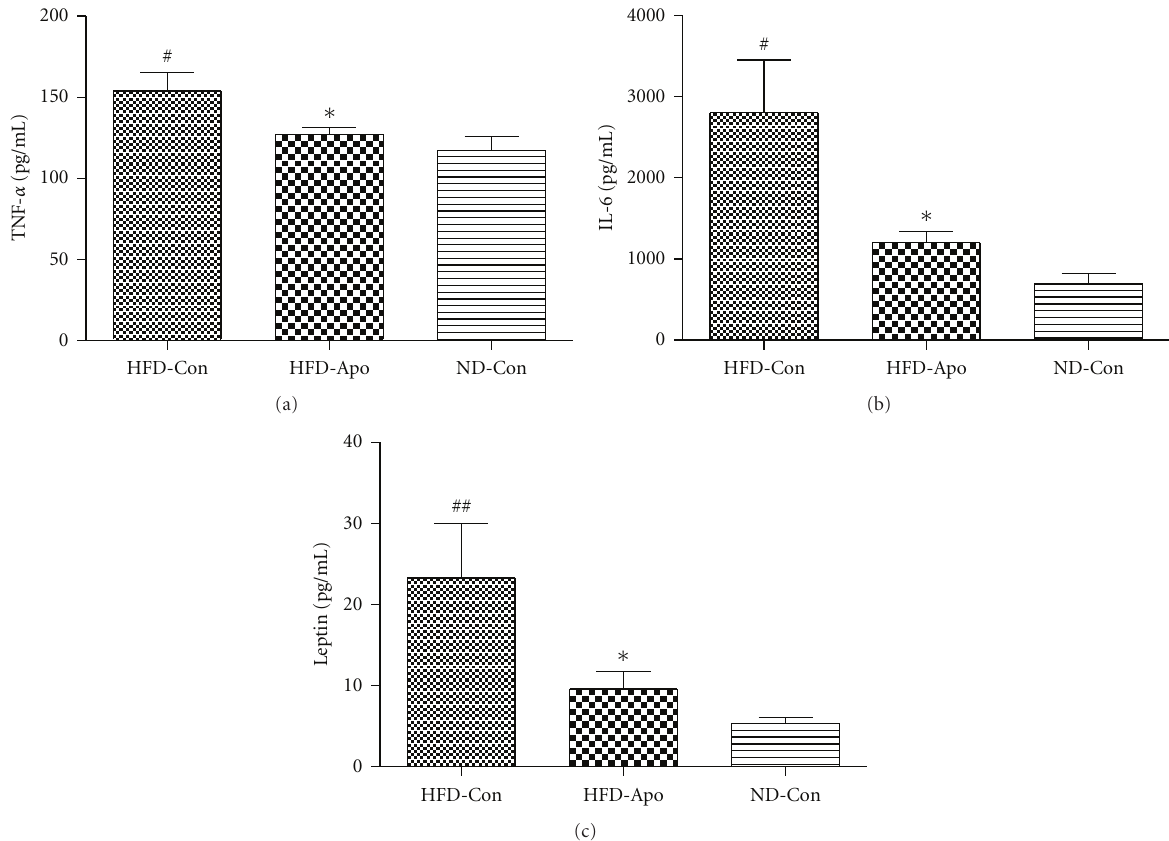
Figure 3: E ff ects of apocynin on the plasma inflammatory markers. (a) Plasma TNF- α levels. It was shown that apocynin decreased the level of plasma TNF- α in HFD-Apo group compared to the HFD-Con group. (b) Plasma IL-6 levels. The plasma IL-6 level in HFD-Apo group is lower than that in HFD-Con group. (c) Plasma leptin levels. Apocynin decreased the level of plasma leptin in HFD-Apo compared with the HFD-Con group. # P < . 05 versus ND-Con group, ## P < . 01 versus ND-Con group, ∗ P < . 05 versus HFD-Con